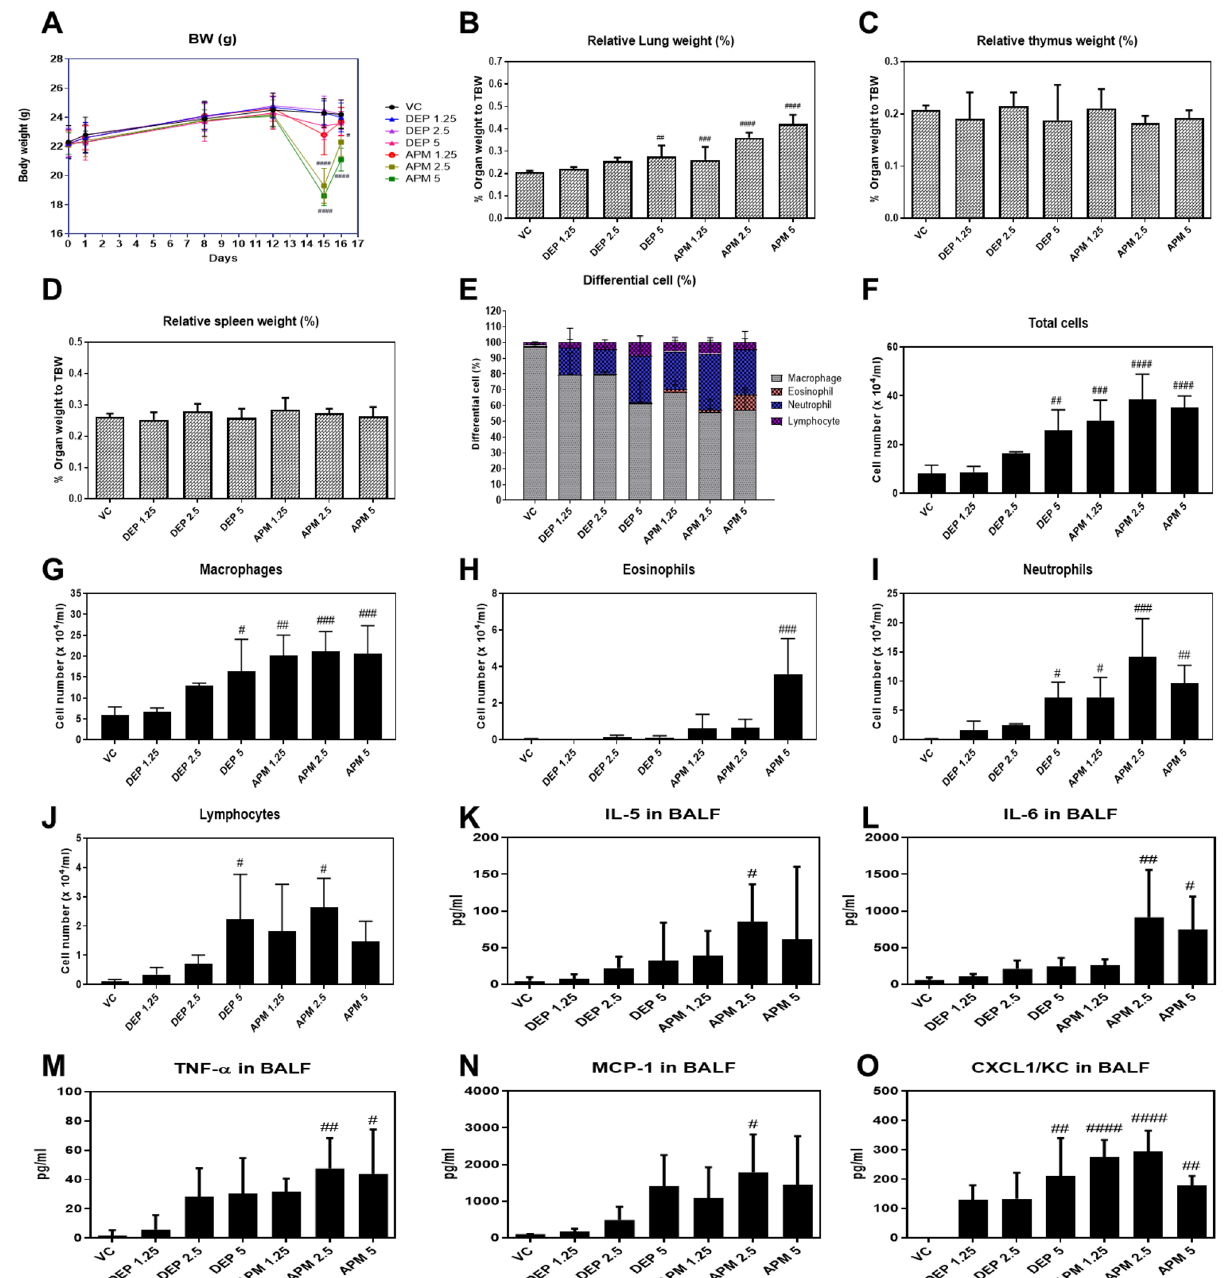
Figure 2. Changes in ( A ) body and ( B – D ) relative organ weights, ( E ) cell population, ( F – J ) the absolute inflammatory cells, and ( K – O ) production of various inflammatory cytokines in the BALF of the vehicle, DEP, and APM-instilled mice. Organ weights were calculated by the following formula: relative organ weight = organ weight (g)/terminal body weight (g) × 100%. Data represent mean ± SD (n = 4 or 5 per group). # p < 0.05, ## p < 0.01, ### p < 0.001, or #### p < 0.0001 vs. VC. DEP diesel exhaust particulate, APM artificial particulate matter, BALF bronchoalveolar lavage fluid, SD standard